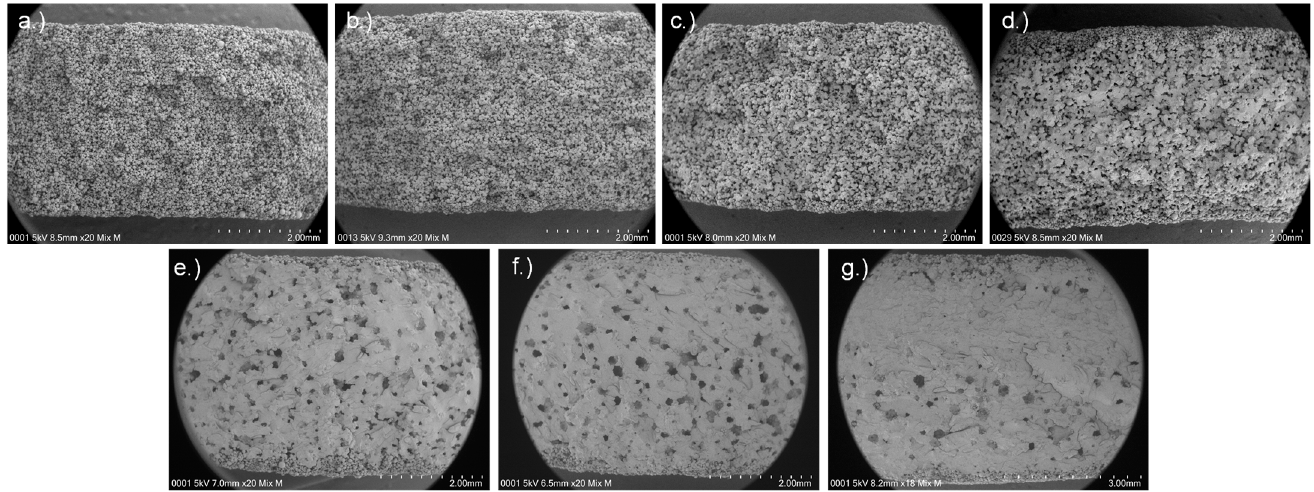
Figure 6. SEM micrographs at 20× magnification from the broken edge of tensile test specimen with different binder loadings: ( a ) 5 wt%; ( b ) 10 wt%; ( c ) 15 wt%; ( d ) 20 wt%; ( e ) 25 wt%; ( f ) 30 wt%; ( g ) 45 wt%.